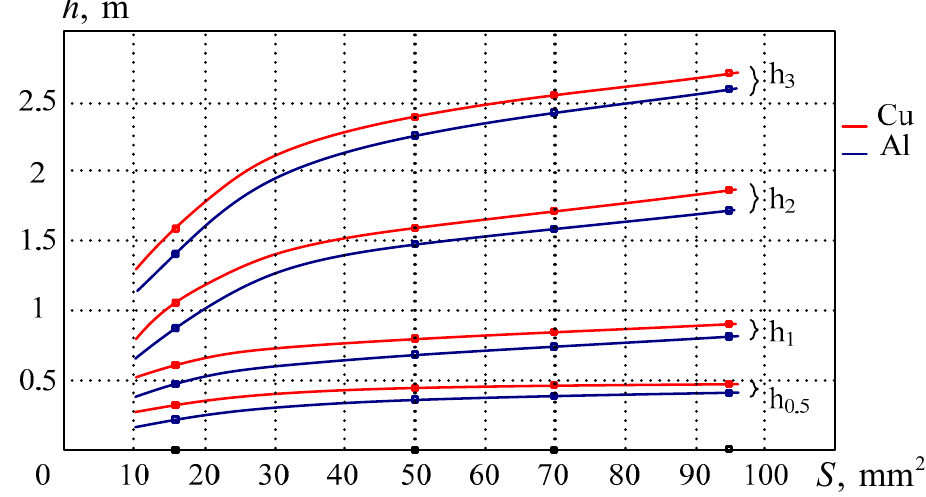
Figure 6. Measurements at different depths.